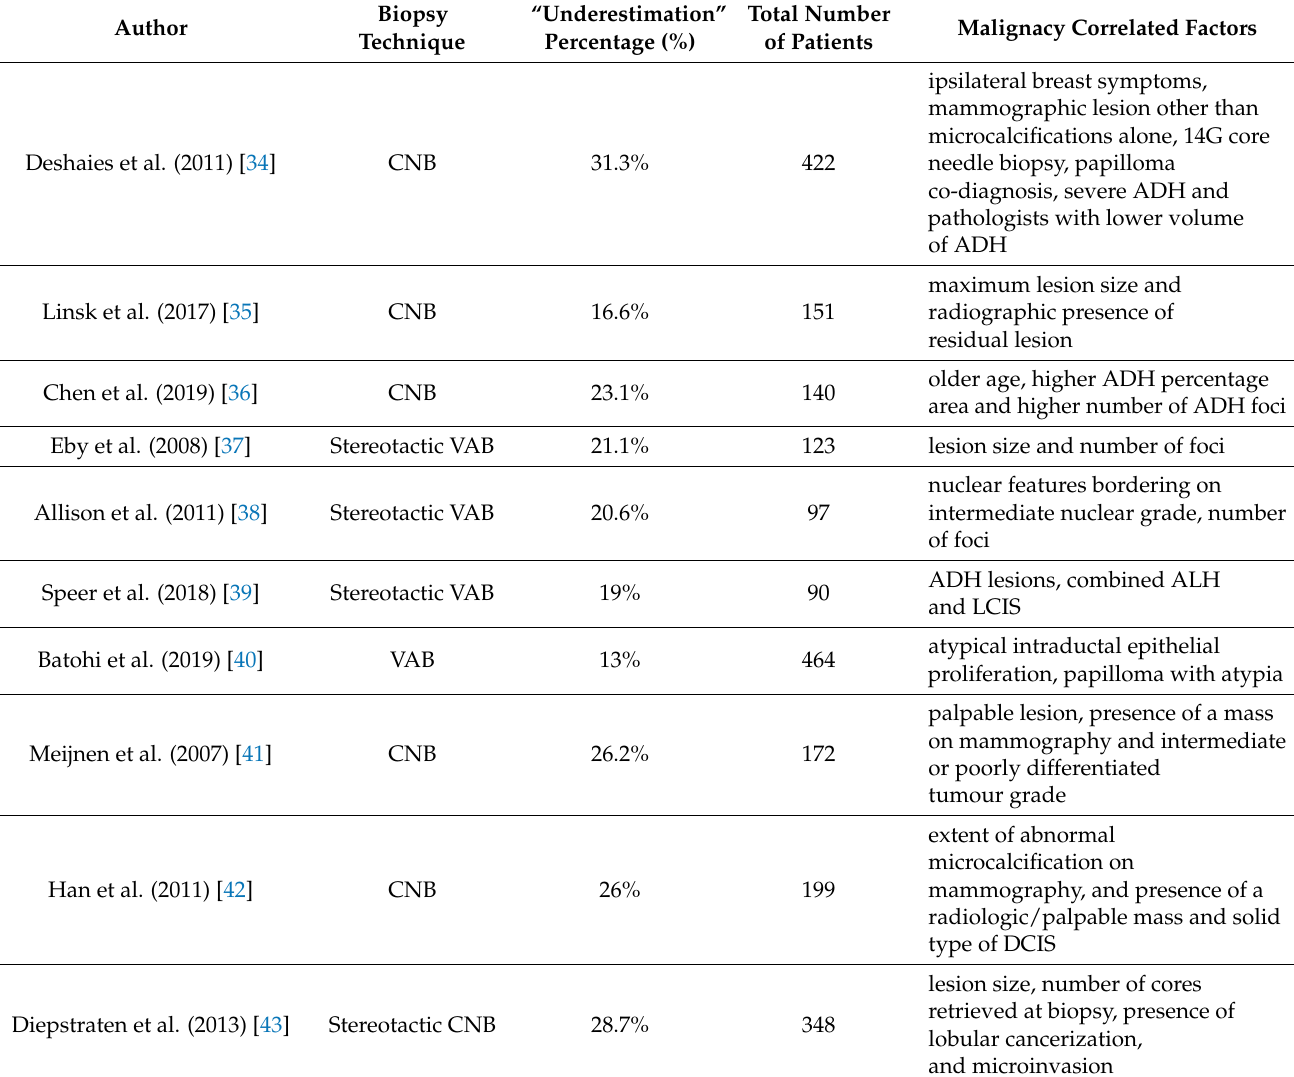
Table 8. Literature review: preoperative underestimation of ductal carcinoma in situ